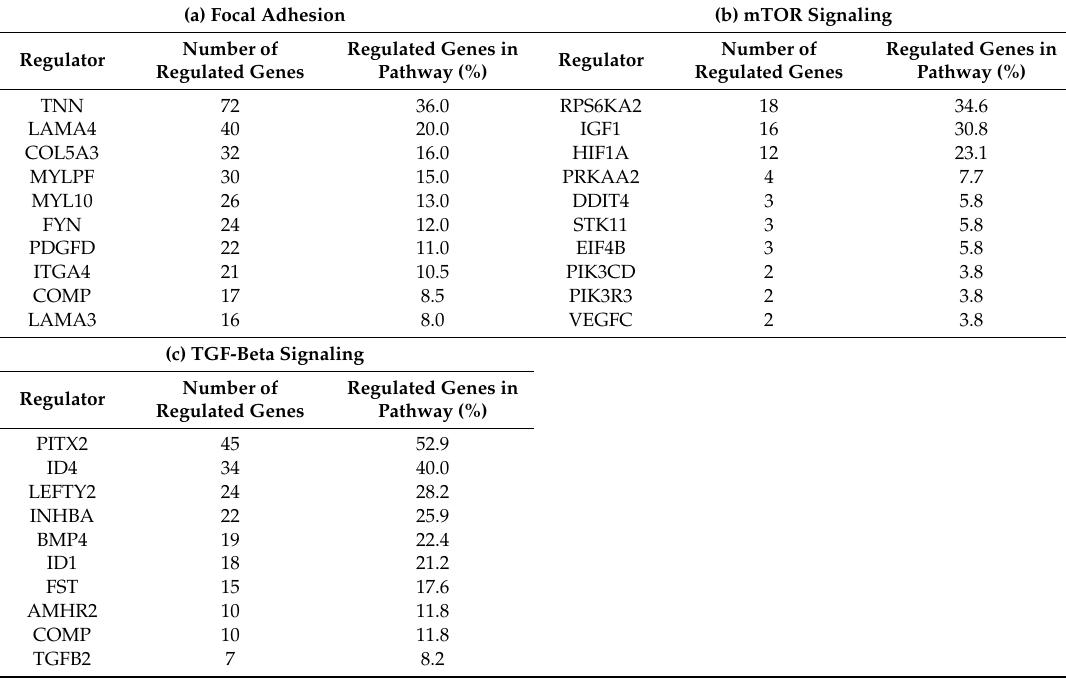
Figure 2. Pathway reconstruction. Inferred dynamic networks of the ( a ) focal adhesion, ( b ) mTOR signaling, and ( c ) TGF-beta signaling pathways. Blue circles are the nodes of the network and represent genes. The lines depict which genes’ mRNA expression level at the current time point, denoted by Y t , a ff ect the genes’ mRNA expression level at a future time point, denoted Y t + 1 . Solid and dashed lines indicate whether this relation is of a stimulating (positive) or suppressing (negative) nature, respectively. For plotting purposes, genes with a total edge strength (sum of all absolute in and out connections of the respective gene) < 0.25 (or < 1 for TGF-beta signaling) were excluded. Table 2. Key regulators of selected